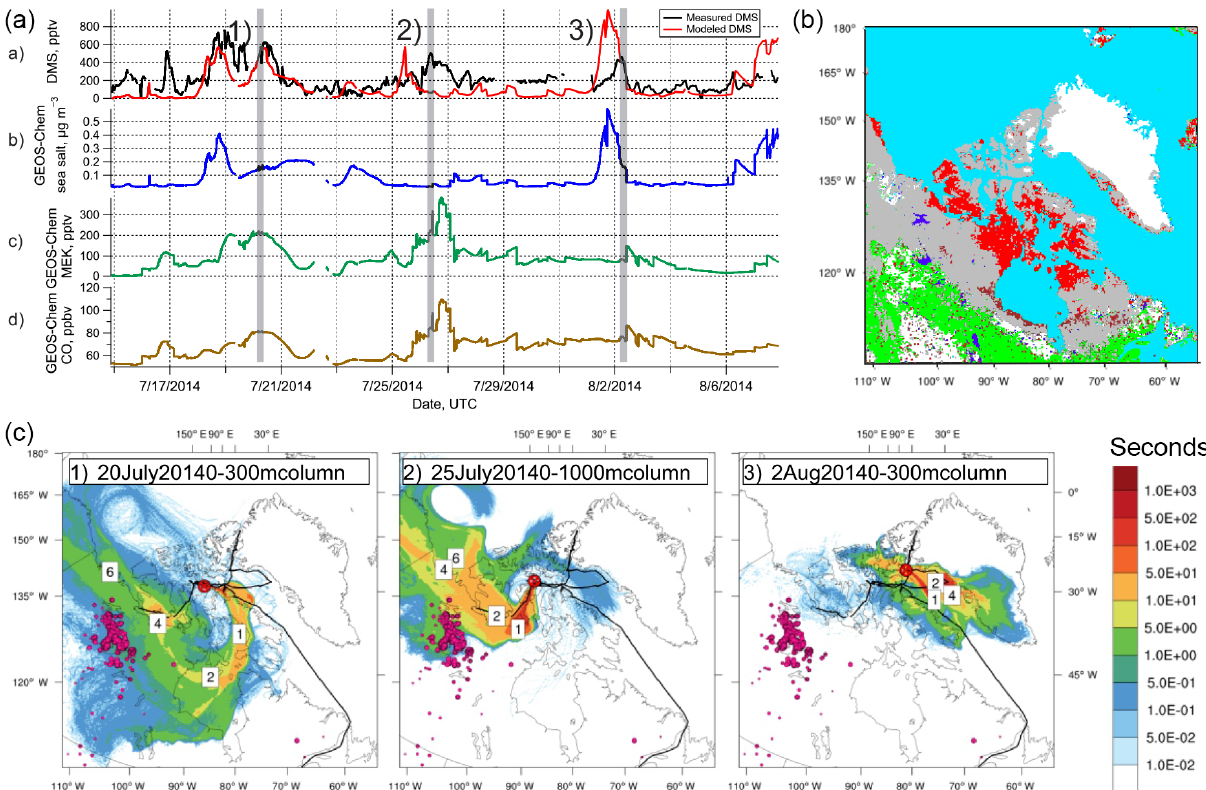
Figure 3. (a) Surface-layer atmospheric time series along Amundsen ship track of (a) measured and GEOS-Chem (GC) simulated DMS; (b) GC simulation of accumulation mode sea salt mass concentration; (c) GC simulation of methyl ethyl ketone (MEK) mixing ratio; (d) GC simulation of carbon monoxide (CO) mixing ratio. (b) Olson Land Cover map of North America showing low-lying tundra (red), other tundra (grey), forest (green), wetlands and marsh (brown), and inland water (dark blue). (c) FLEXPART-WRF potential emissions sensitivity (PES) simulation plots showing the likely origin of the air mass at the ship position. The colour scale in seconds corresponds to time spent in the lower 300–1000m (marked on each plot) before arriving at the ship position. The three plots correspond to the three periods shown by the numbers and shaded bars in (a) , showing examples of (1) transport from lower latitudes, including Hudson Bay (2) continentally influenced air (3) local marine influence from Baffin